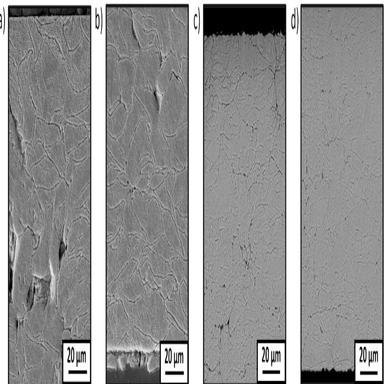
Microstructure of the copper material a) far from and b) near to the substrate of as-sprayed condition (ASC-1), and c) far from and d) near to the substrate of annealed condition (ANC-2).